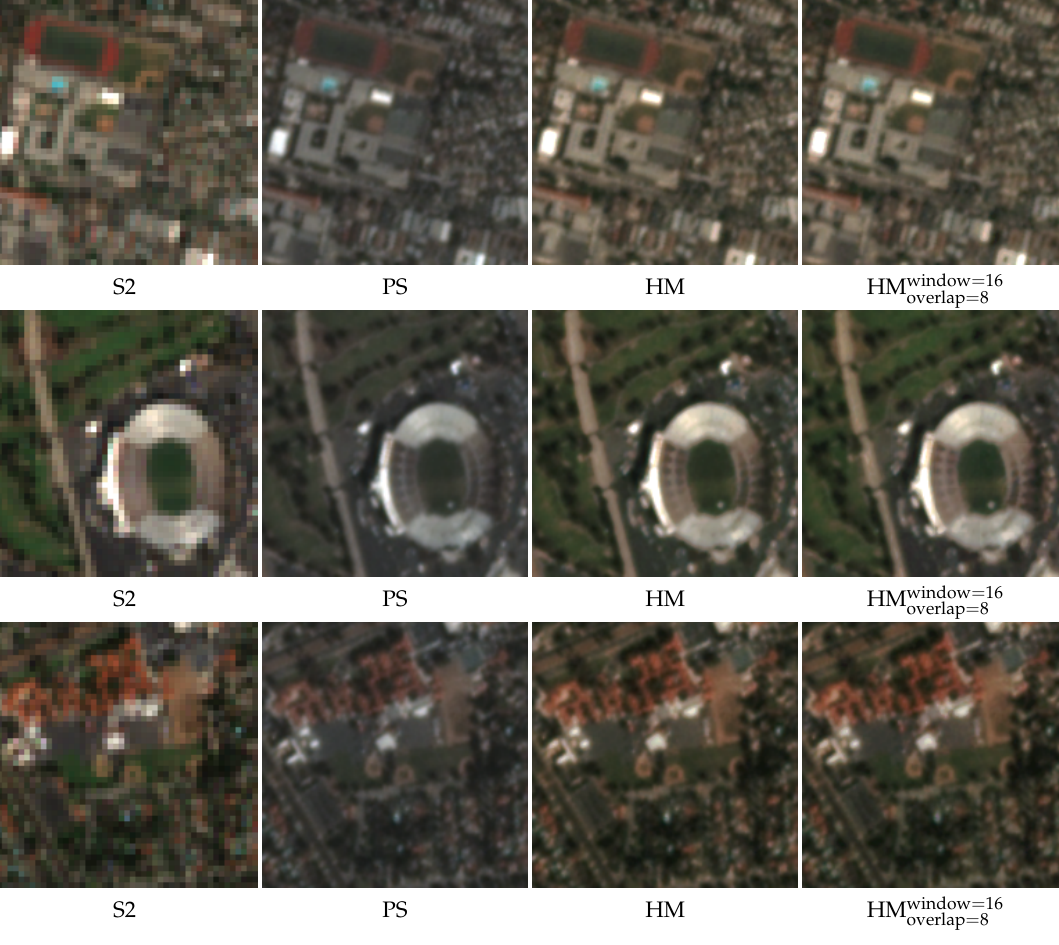
Figure 6. Histogram Matching (HM) applied to three PS tiles with S2 tiles as templates. Standard HM applied to the whole tile and HM by windowing (HM window = 16 overlap = 8